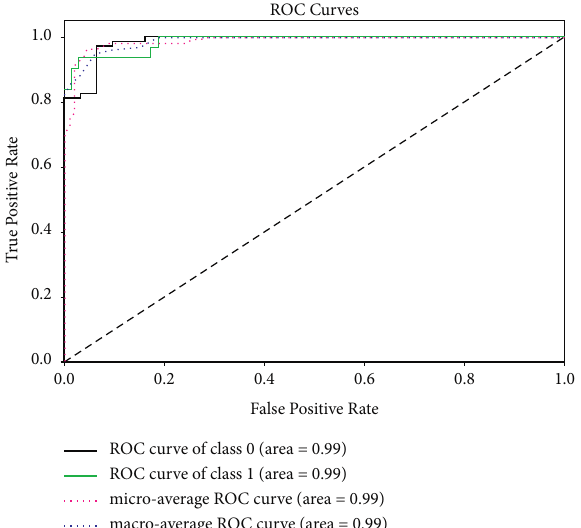
Figure 4: ROC curves for different classes of the dataset generated by the employed ensemble